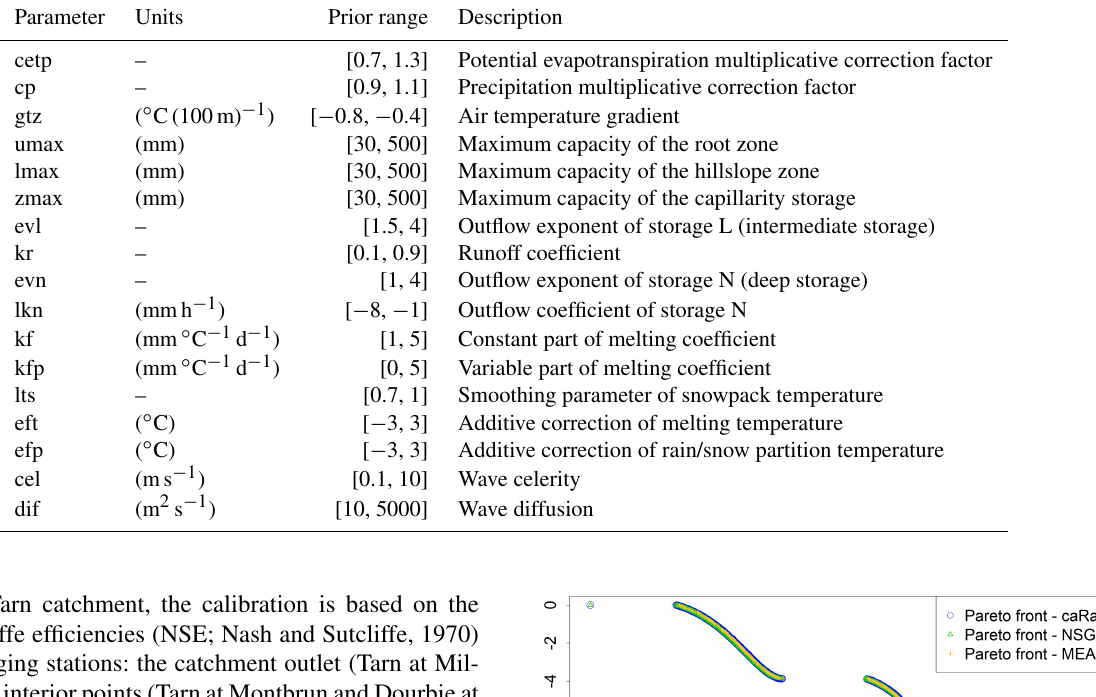
Table 1. Parameters to calibrate for MORDOR-TS and bounds of variation.